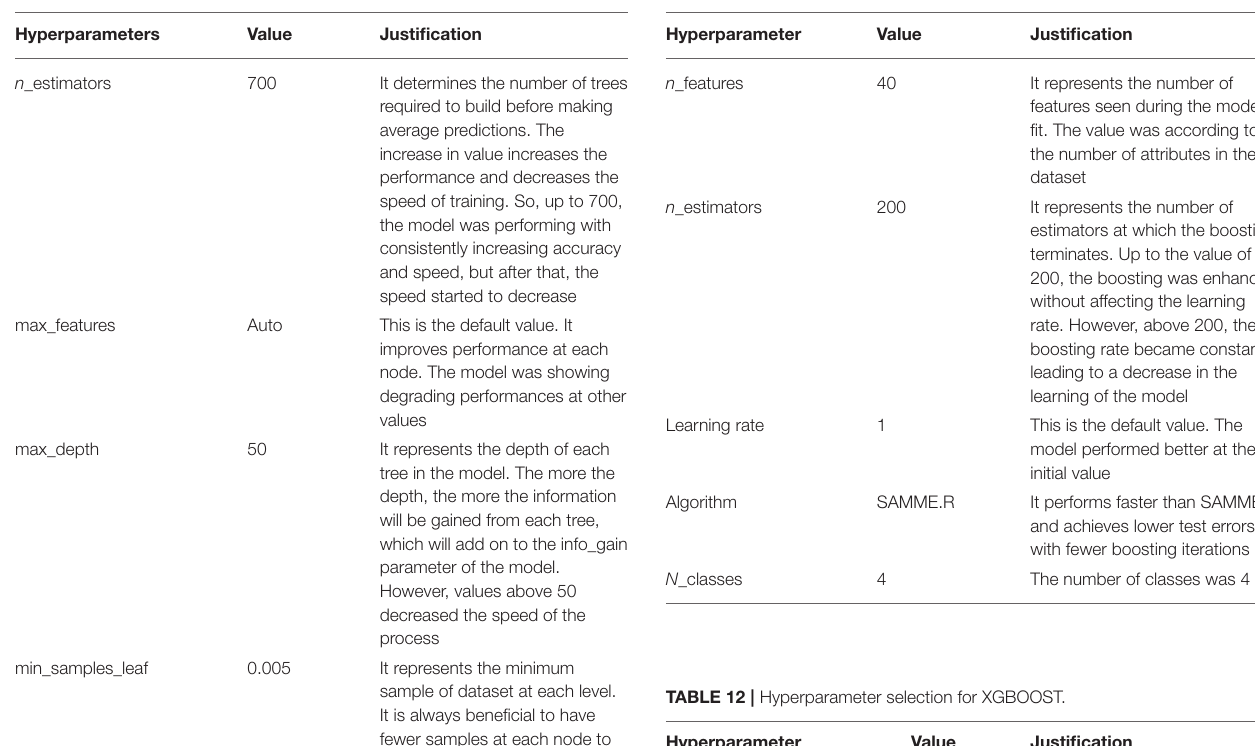
TABLE 10 | Hyperparameter selection for RF. TABLE 11 | Hyperparameter selection for AdaBoost.